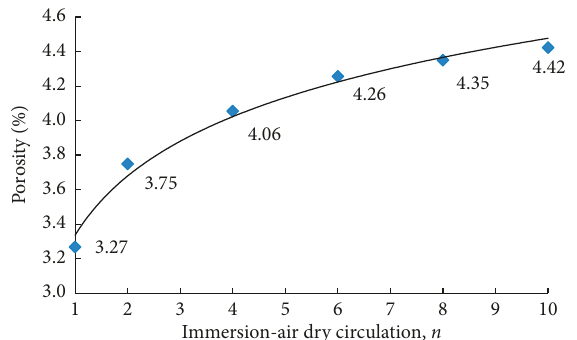
Figure 13: Porosity curve of rock sample under water-rock